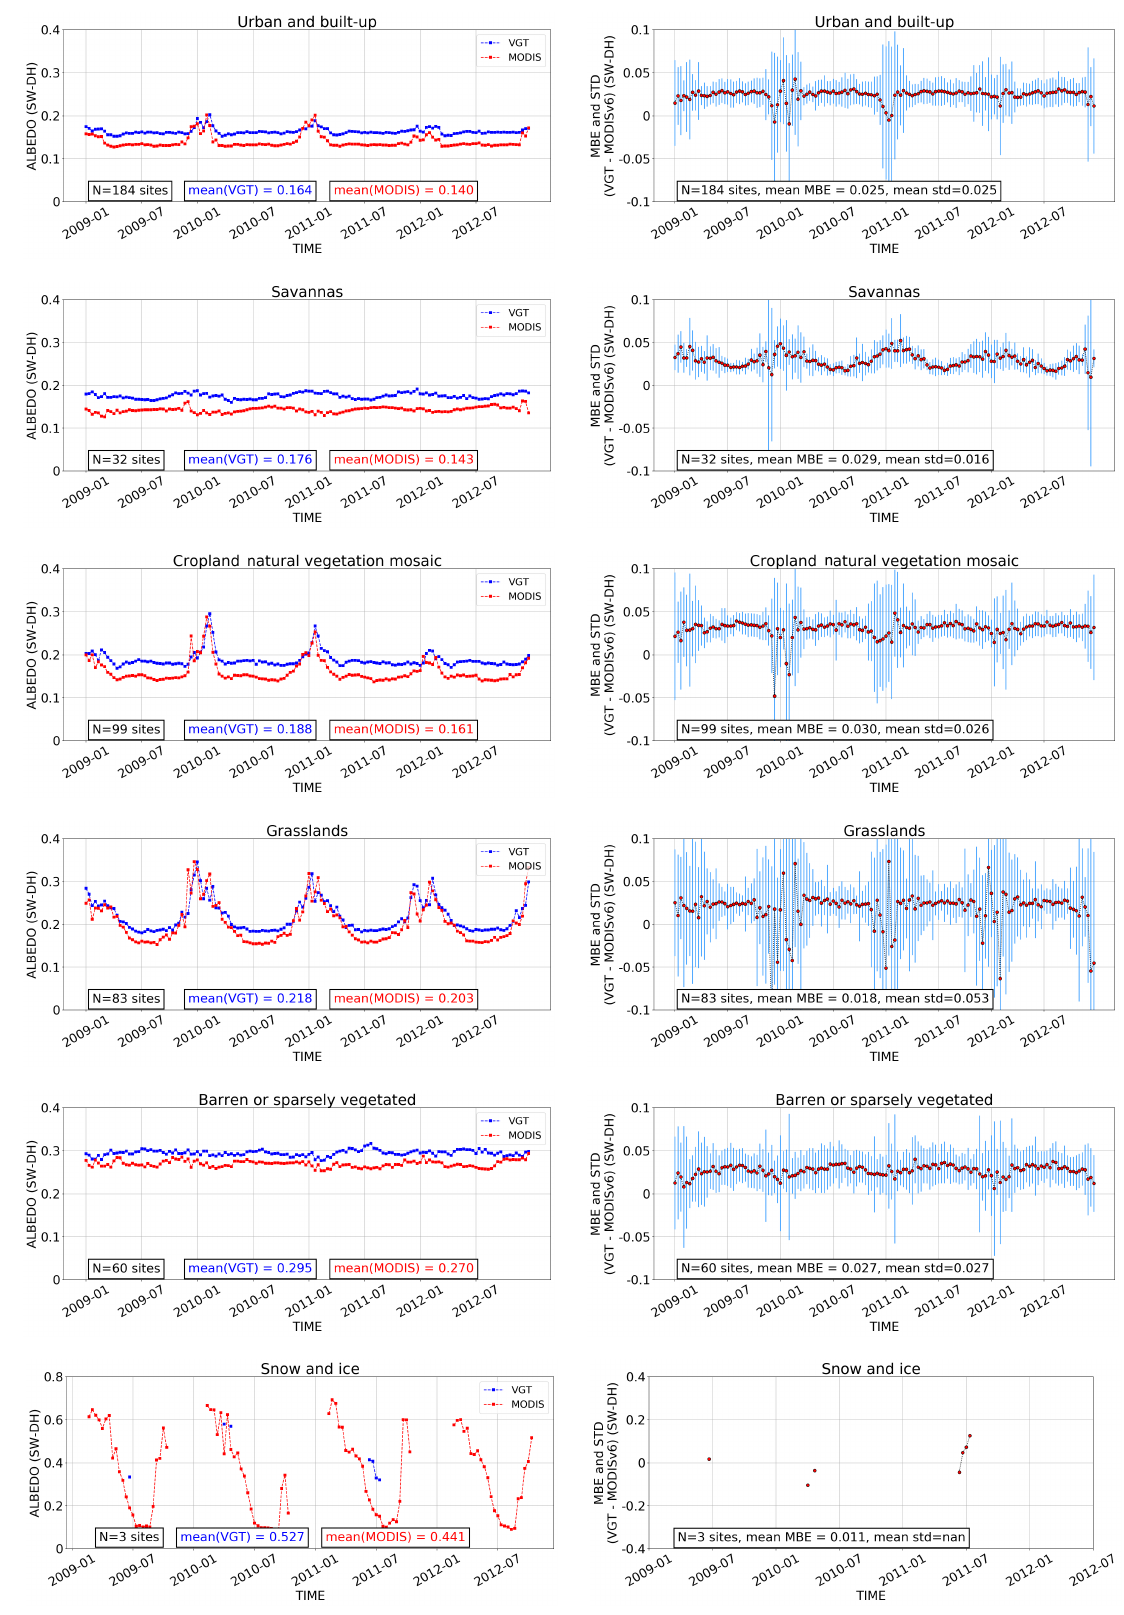
Figure A5. Time series of VGT versus MODIS for the other 12 land cover types over the period